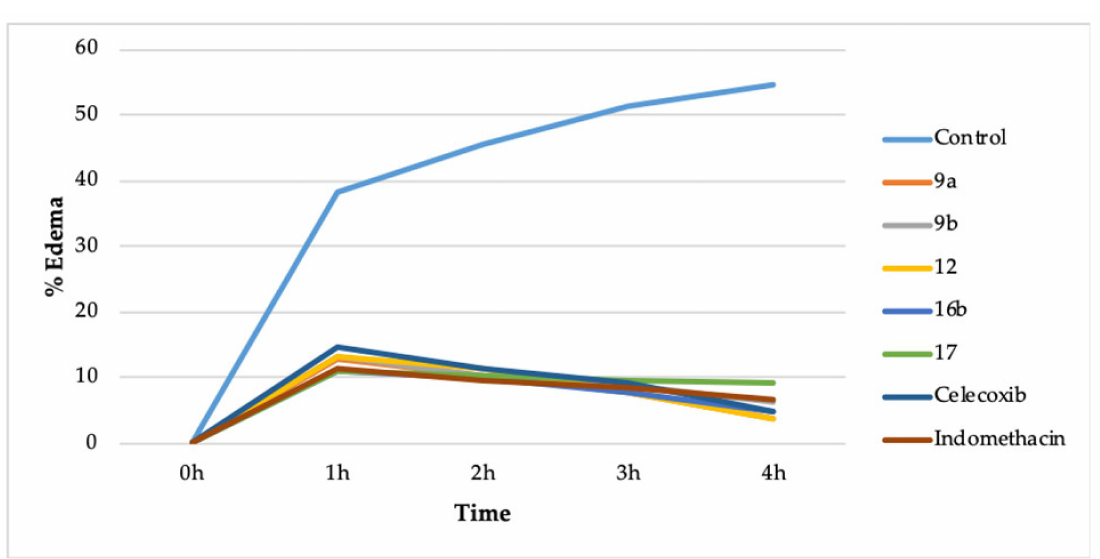
Figure 2. In vivo action of 9a , 9b , 12 , 16b , 17 , celecoxib, and